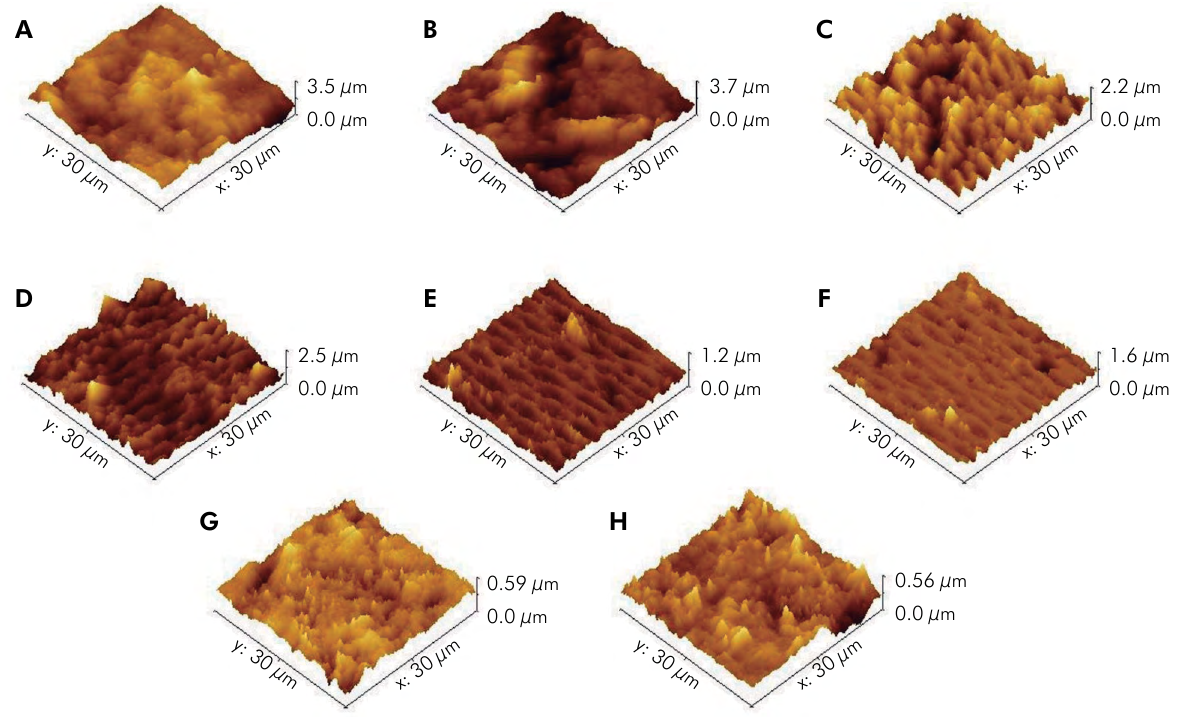
Figure 2. 3D images of enamel surface topography (30 × 30 μ m) under the atomic force microscope. (A) enamel eroded and treated with distilled water, (B) enamel exposed to cigarette smoke and eroded and treated with distilled water, (C) enamel eroded and treated with NaF, (D) enamel exposed to cigarette smoke and eroded and treated with NaF, (E) enamel eroded and treated with SnF , (F) enamel exposed to cigarette smoke and eroded and treated with SnF 2 chitosan, (H) enamel exposed to cigarette smoke and eroded and treated with